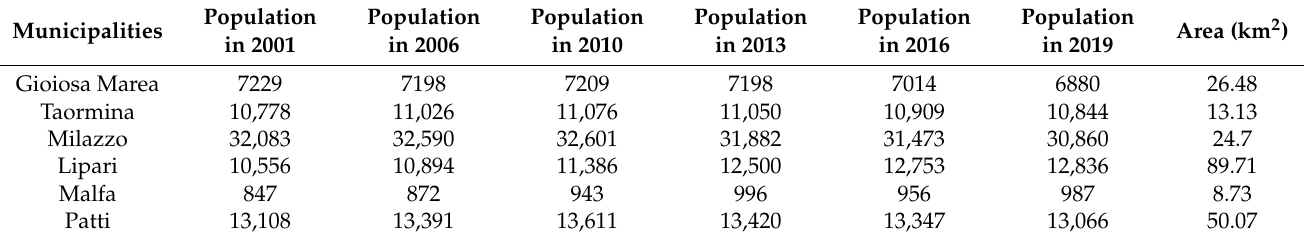
Table 1. Population and area of coastal municipalities of the province of Messina affiliated with the pocket beaches (PBs) studied in the BESS